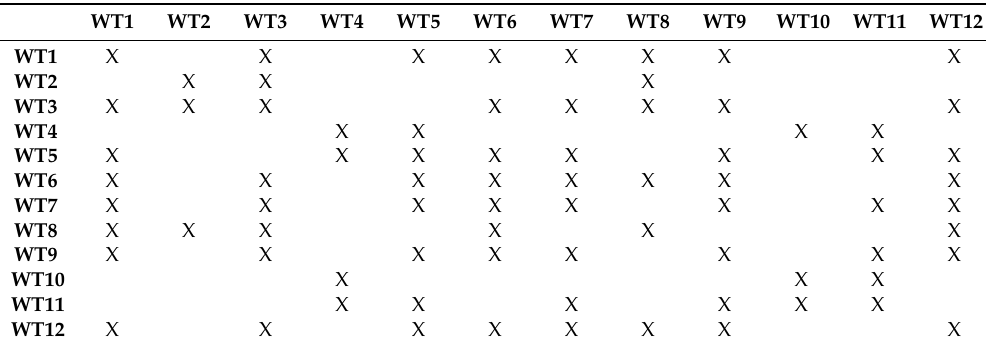
Table 2. Pairs of wind turbines (WTs) that did not have a significantly different power performance at the α “ 0.05 significance level.